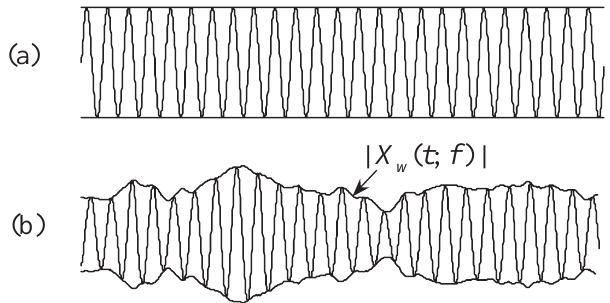
Fig. 6. The envelope indicator is based on the property that the envelope of a pure tone is constant (a), whereas that of a random noise is random (b). its variance is identically zero. On the other hand, a random noise, by definition, has a non-zero variance and this is independently of its spectral density and probability density function. These observations are relative to ensemble statistics, but they also hold for certain time statistics provided the signals are ergodic (which simply means that time statistics converge to deterministic values, whatever these